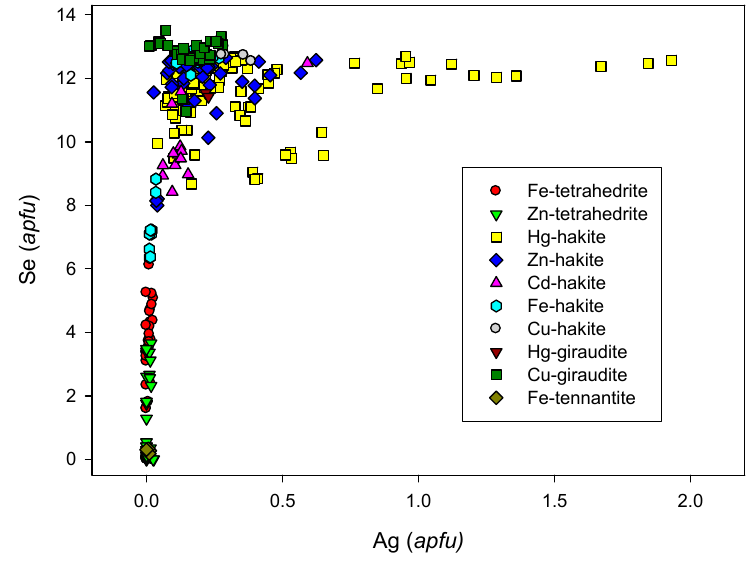
Figure 70. Ag vs. Se ( apfu ) graph for tetrahedrite group of minerals from P ř íbram.